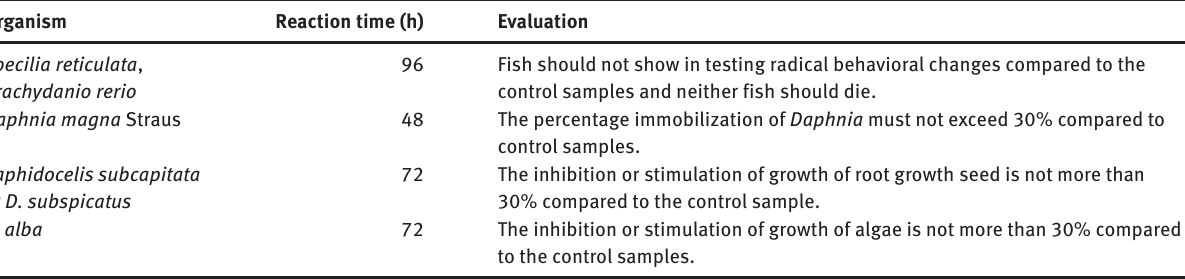
Table 2: Requirements for the results of ecotoxicological tests according to Decree No. 294/2005. Organism Reaction time (h)